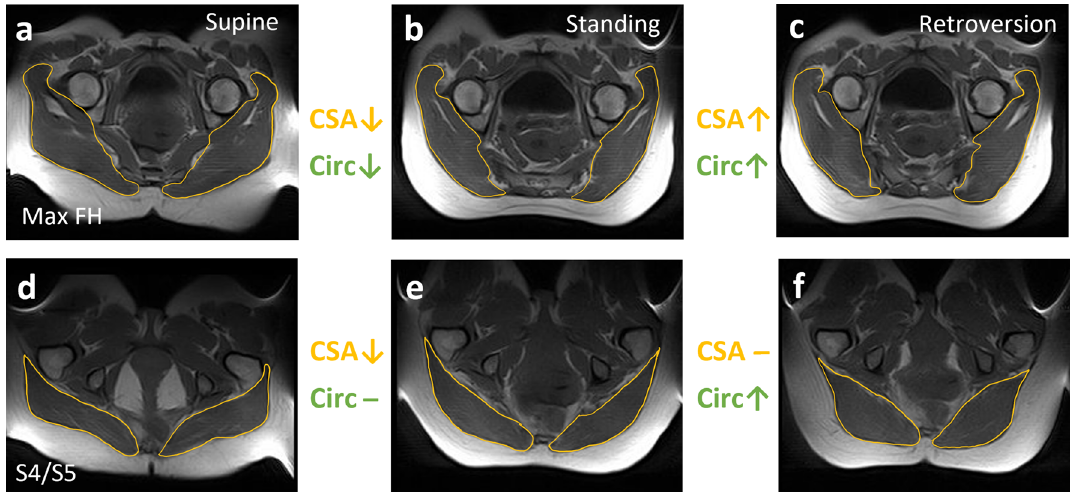
Figure 2. Example changes in gluteus CSA (yellow) and circularity (Circ, green) with posture ( ↓ = decrease, ↑ = increase, – = no change). At max FH for both CSA and circularity, there was up to a 15% decrease from supine to standing ( a , b ) and up to a 22% increase from standing or flexion to retroversion (b to c). At S4/S5, from supine to standing though CSA decreased by 16%, there was no change in circularity ( d , e ). Additionally, from standing or flexion to retroversion, though there was no change in CSA, circularity increased up to 24% ( e , f